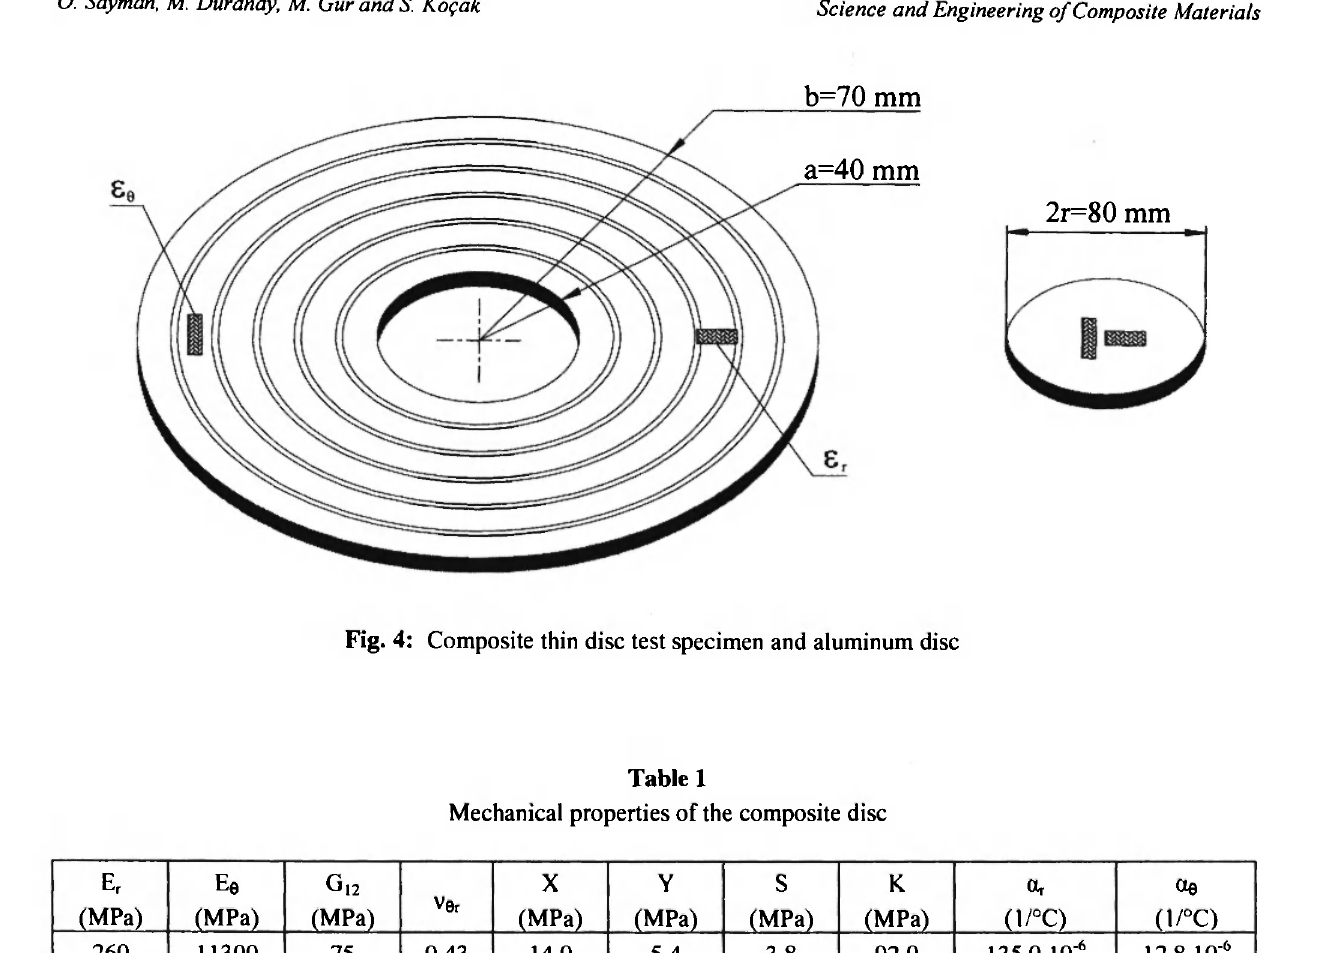
Fig. 4: Composite thin disc test specimen and aluminum disc